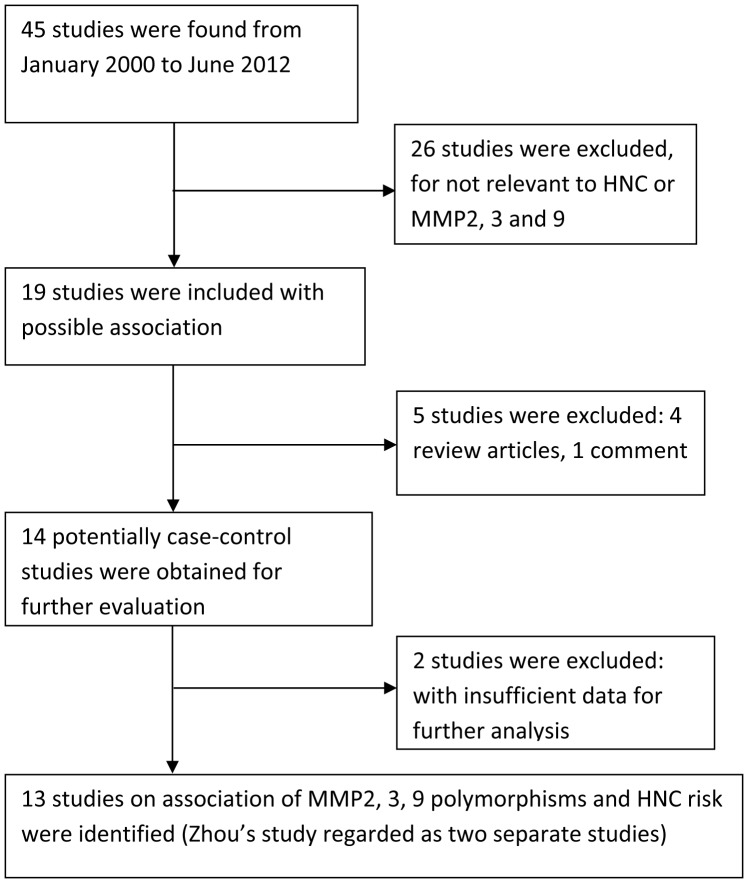
PRISMA flowchart of study identification.